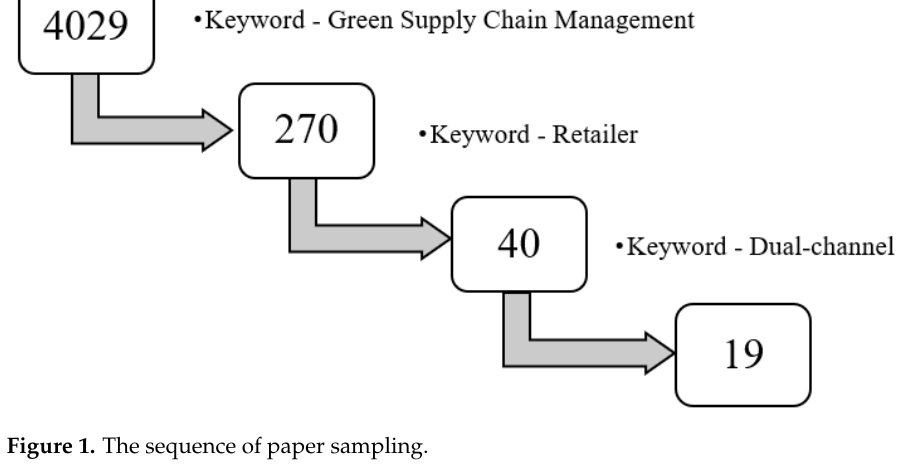
Figure 1. The sequence of paper sampling.